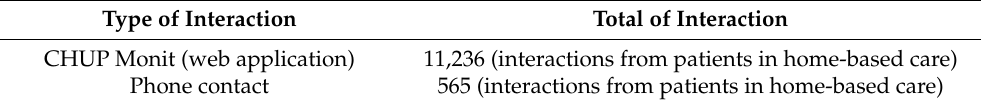
Table 1. Patient